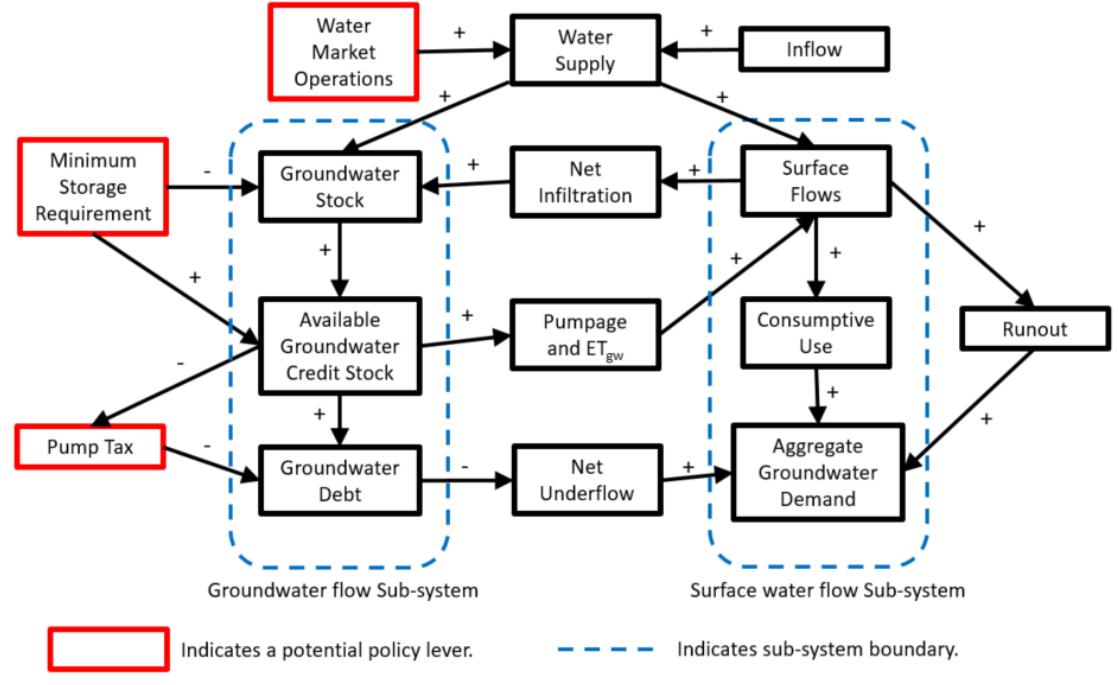
Figure 1. Causal loop diagram of the general groundwater system structure [17,18].